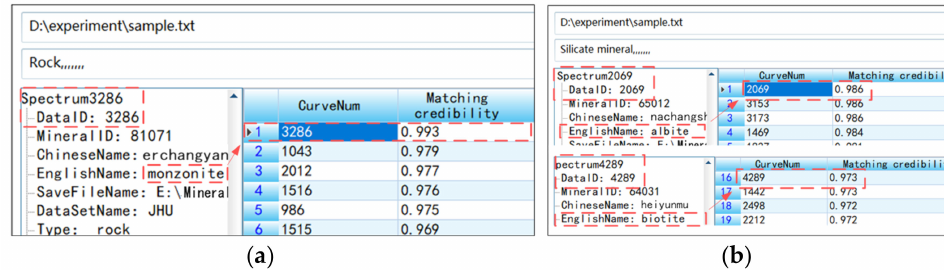
Figure 10. Identification of unknown rock and its composition by the RockSL. ( a ) The spectral curve of the monzonite (No. 3286) matched well with the spectra of the specimen. ( b ) Mineral curves of albite (No. 2069) and biotite (No. 4289) matched well with the spectra of the specimen.